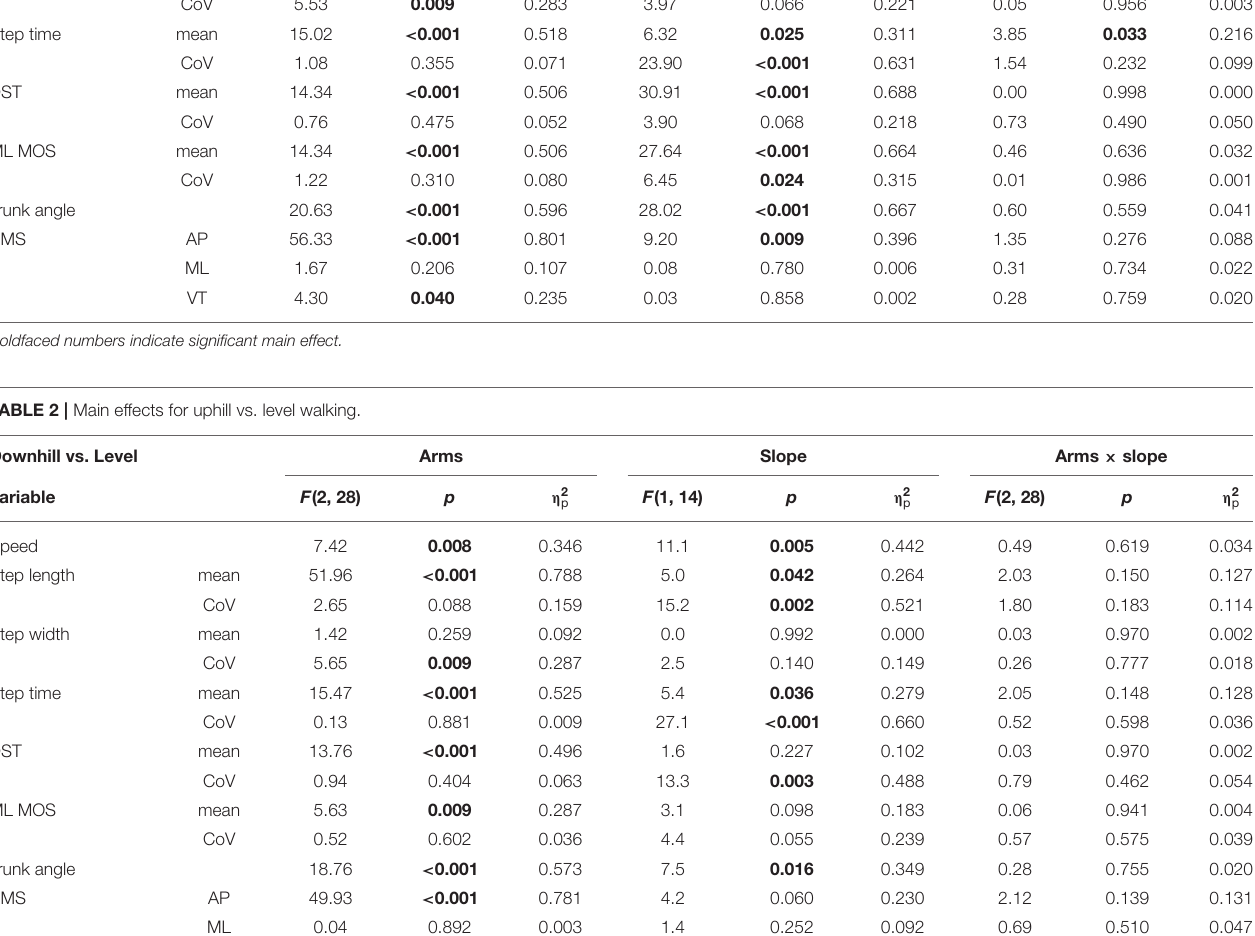
TABLE 1 | Main effects for uphill vs. level walking. Uphill vs. Level